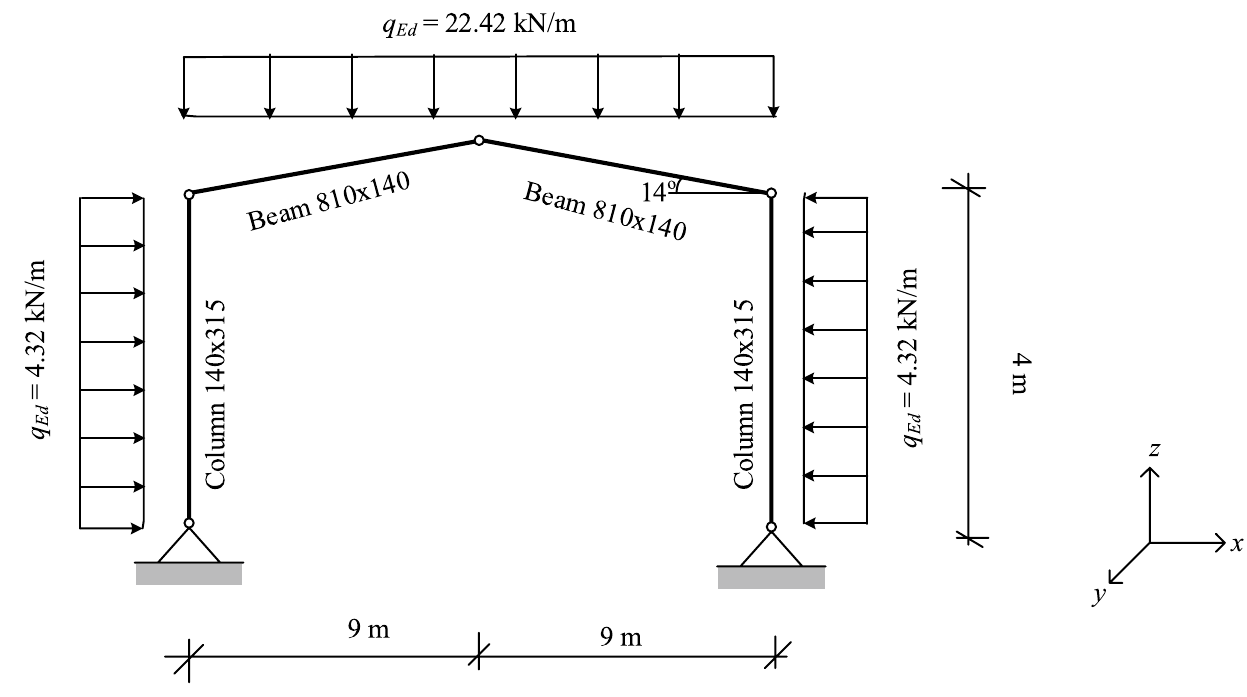
Fig. 3 Cross section through building structure with the applied variable characteristic actions